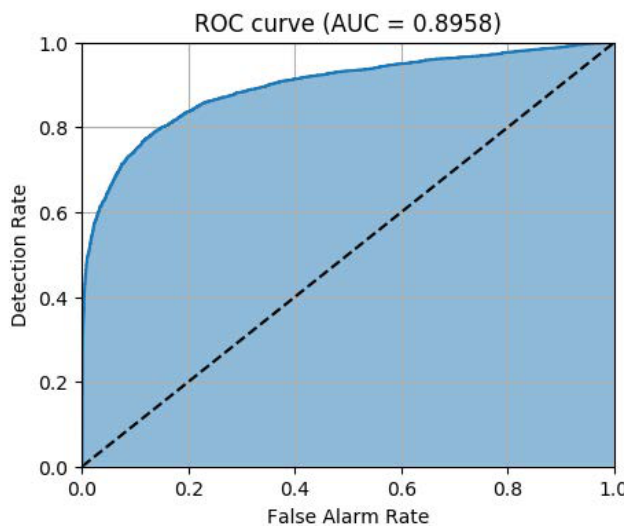
Figure 11. ROC curve with the learning parameter β of Figure 10 for the test data set.